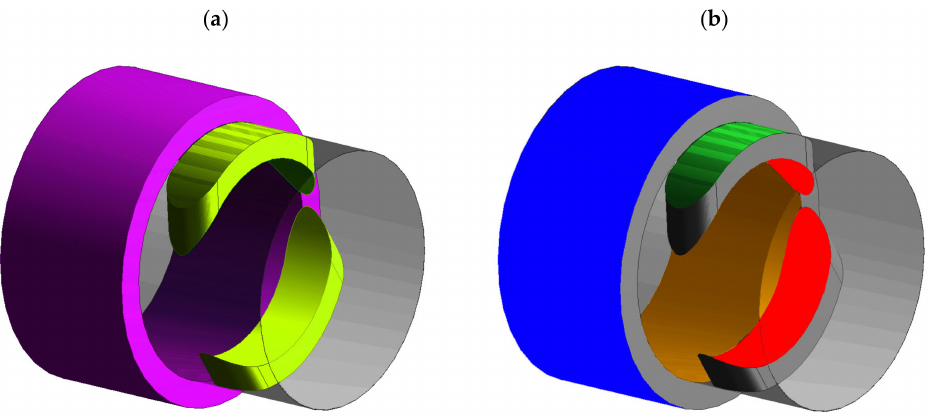
Figure 20. Domain geometry and border conditions. ( a ) Parts of domain: purple—peripheral channel; transparent grey—gap between the commutation tube and the socket; yellow—commutation windows. ( b ) Border conditions: red—inlet; blue—outlet; green and